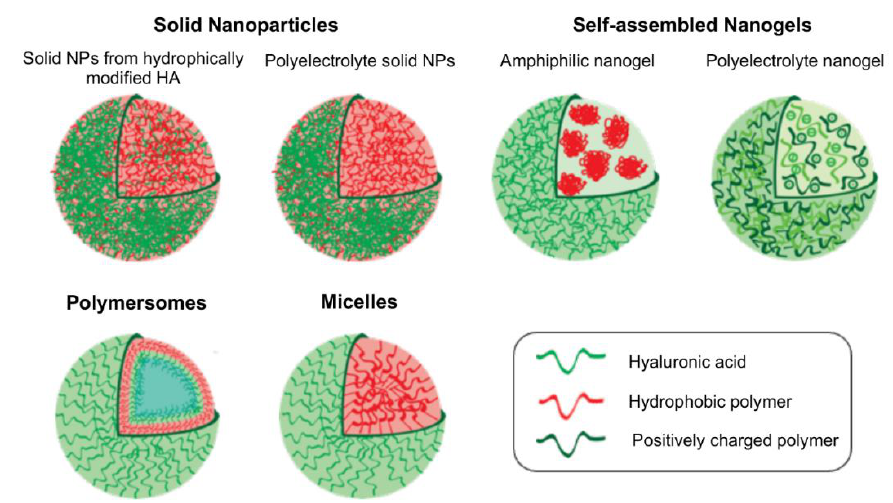
Figure 1. Schematic representation of different hyaluronic acid (HA)-based polymeric nanocarriers.